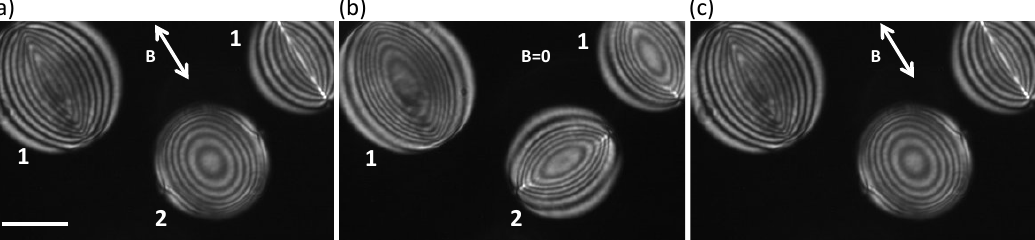
Figure 4. ( a – f ) Transition of a SSY nematic gem from the concentric to the bipolar configuration under a 0.4 T magnetic field that is rotating counterclock-wise at 5 deg s − 1 (see also Movie 3). The instantaneous orientation of the magnetic fields is sketched in each panel. For clarity, micrographs are taken without polarizers. Elapsed times from frame ( a ) are 110 s ( b ), 191 s ( c ), 224 s ( d ), 241 s ( e ), and 373 s ( f ). Red dots in panel ( f ) mark the position of the two surface defects. ( g ) Final bipolar configuration observed between crossed polarizers. ( h ) Computed transmittance corresponding the director field sketched in ( i ) that matches the experimental pattern in ( g ). Scale bar is 100 µ m.